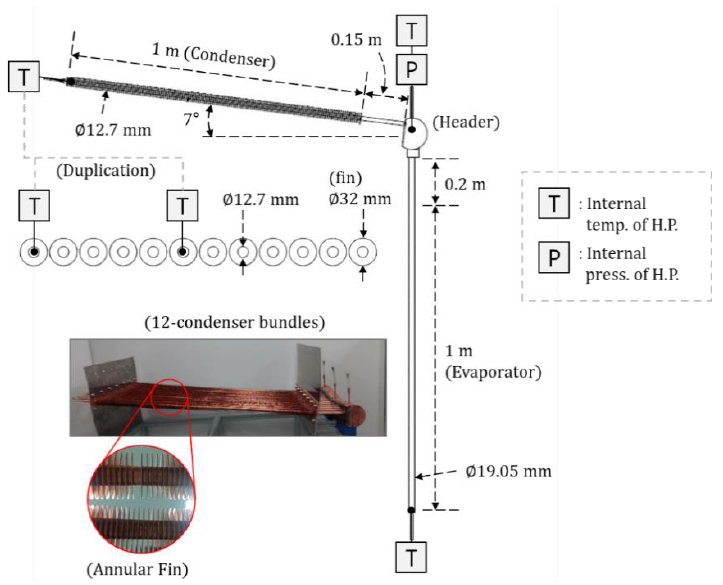
Figure 4. Schematic diagram of a laboratory-scale FHP model.